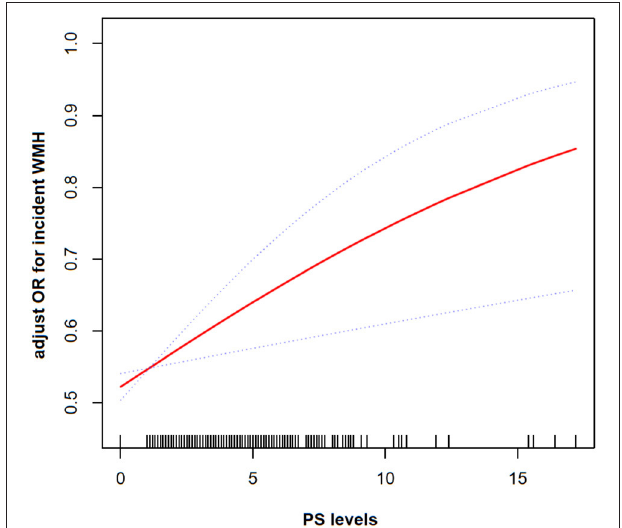
FIGURE 2 | The smoothing curves illustrating the relationship between PS and frequency of WMH. A dose-response relationship between them was detected after adjusting for gender, age, SBP, DBP, BMI, HT, DL, DM, HDL, BS, HAB1C, smoking history, and drinking